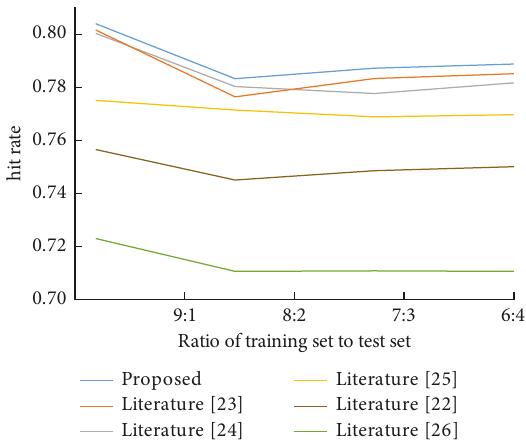
Figure 5: Prediction performance comparison